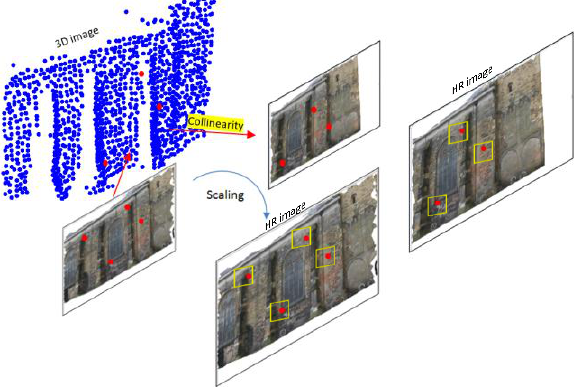
Figure 4. Keypoints estimation in the high resolution